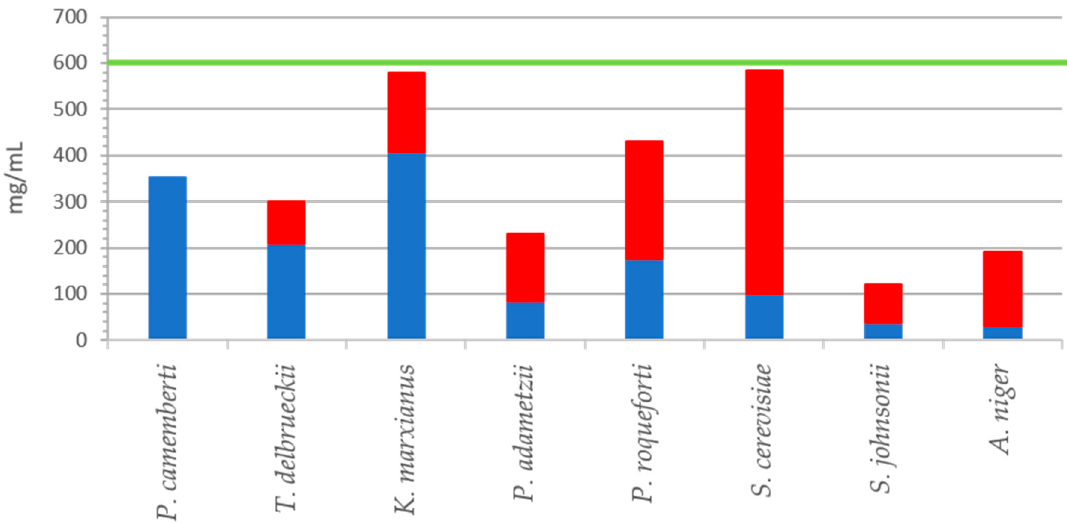
Figure 4. Determination of the dihydrocoumarin (blue bar) and coumarin (red bar) titer after seven days of fermentation and using ethanolic solution of 6 as an internal standard. The starting coumarin concentration was 0.6 g/L (green line).